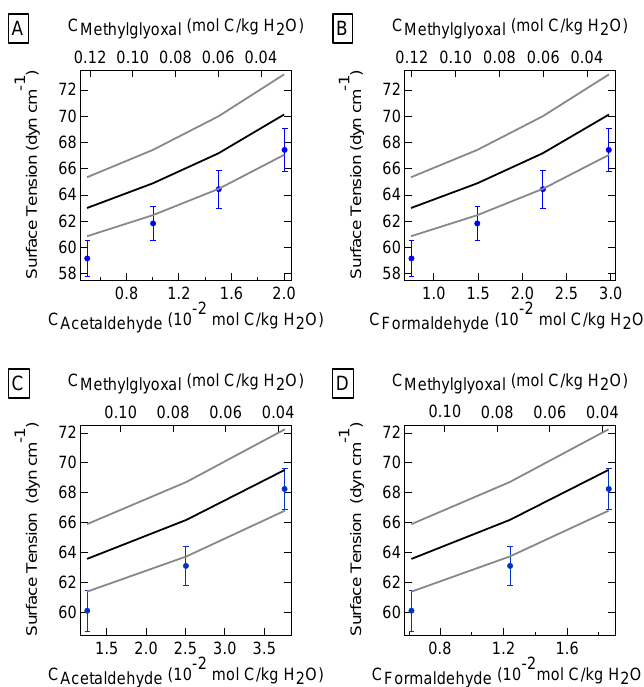
Figure 4. Surface tension data for ternary (acetaldehyde, formaldehyde and MG) mixtures in 3.1 M AS solutions. The molar ratios of acetaldehyde to formaldehyde are 1:3 ( A and B ) and 1:1 ( C and D ). The total organic concentration was constant at 0.05 M. The black line shows Henning model predictions using the parameters listed in Table 1. The grey lines show the confidence interval of the predicted data.